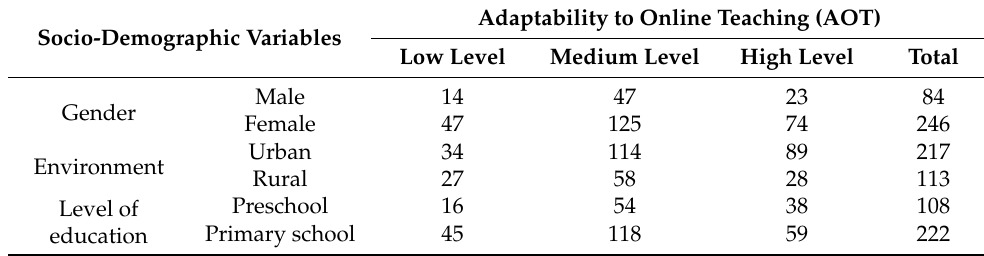
Table A1. AOT depending on various socio-demographic